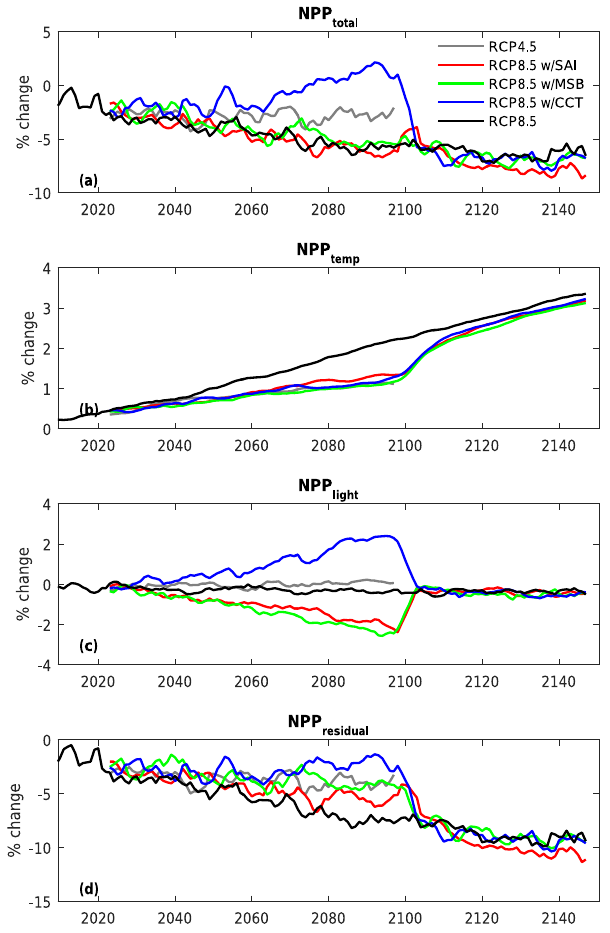
Figure 7. Time series of the 5-year running mean of globally aver- aged NPP (%) calculated offline using Eqs. (1)–(3) and plotted as the percent change relative to the 1971–2000 average in the histor- ical run. The residual (NPP total − NPP temp − NPP light ) represents the circulation-induced changes. Note the different scales on the y axes. See Table 1 for an explanation of the different calculations